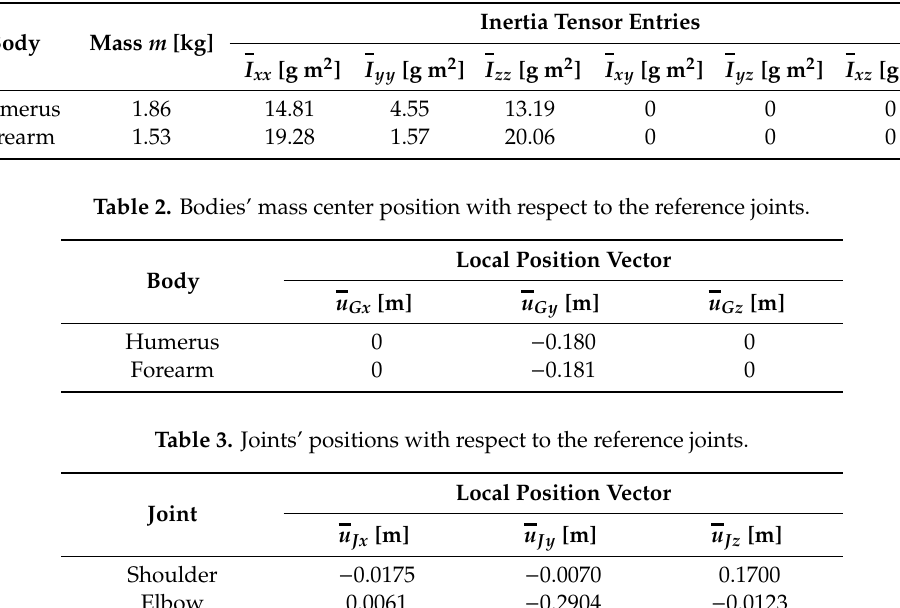
Table 1. Bodies’ inertial properties.